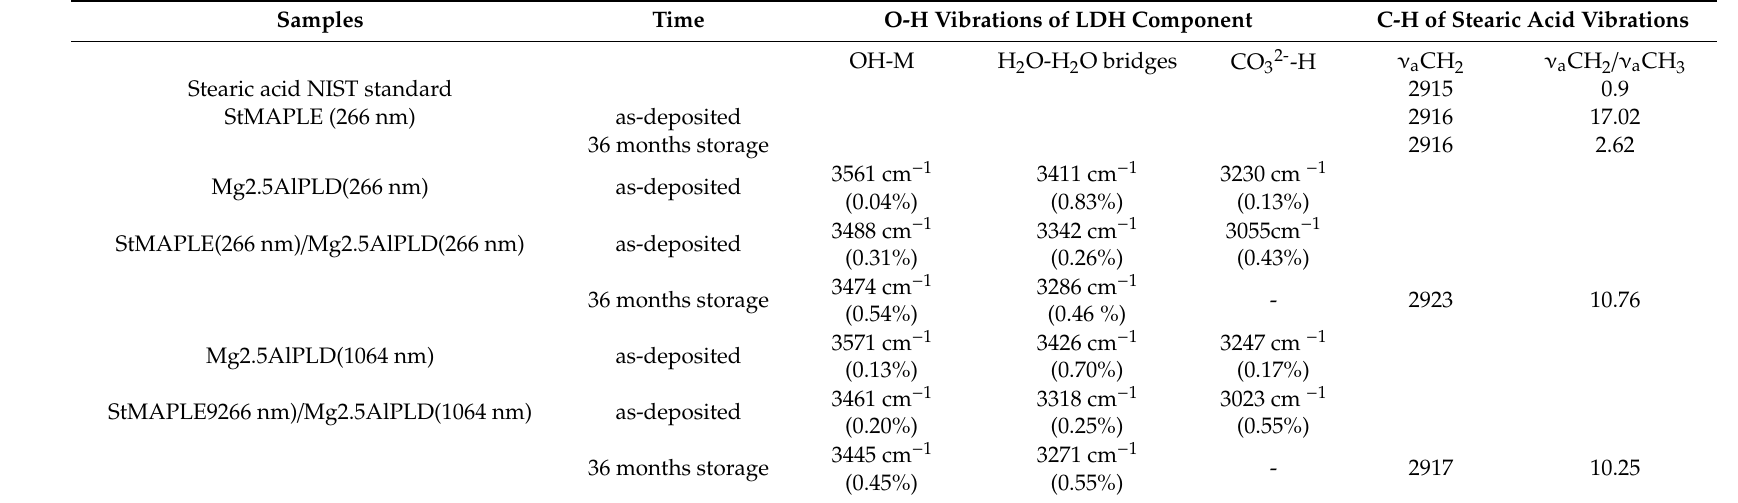
Table 3. FT-IR analyses of the as-deposited